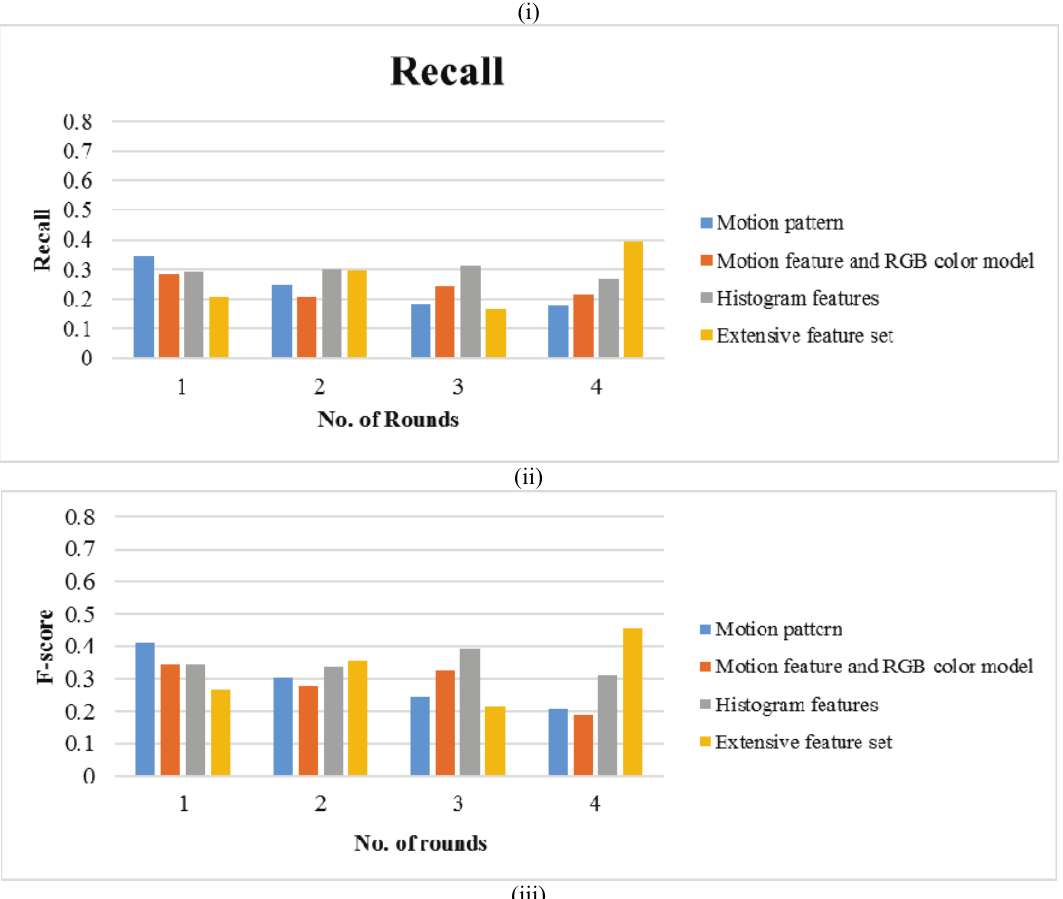
Fig. 8. Comparison plot of Mean of 3D- animated video data set (i) Precision, (ii) recall and (iii) F-score values for different rounds of retrieval obtained by the proposed CBVR system and other existing